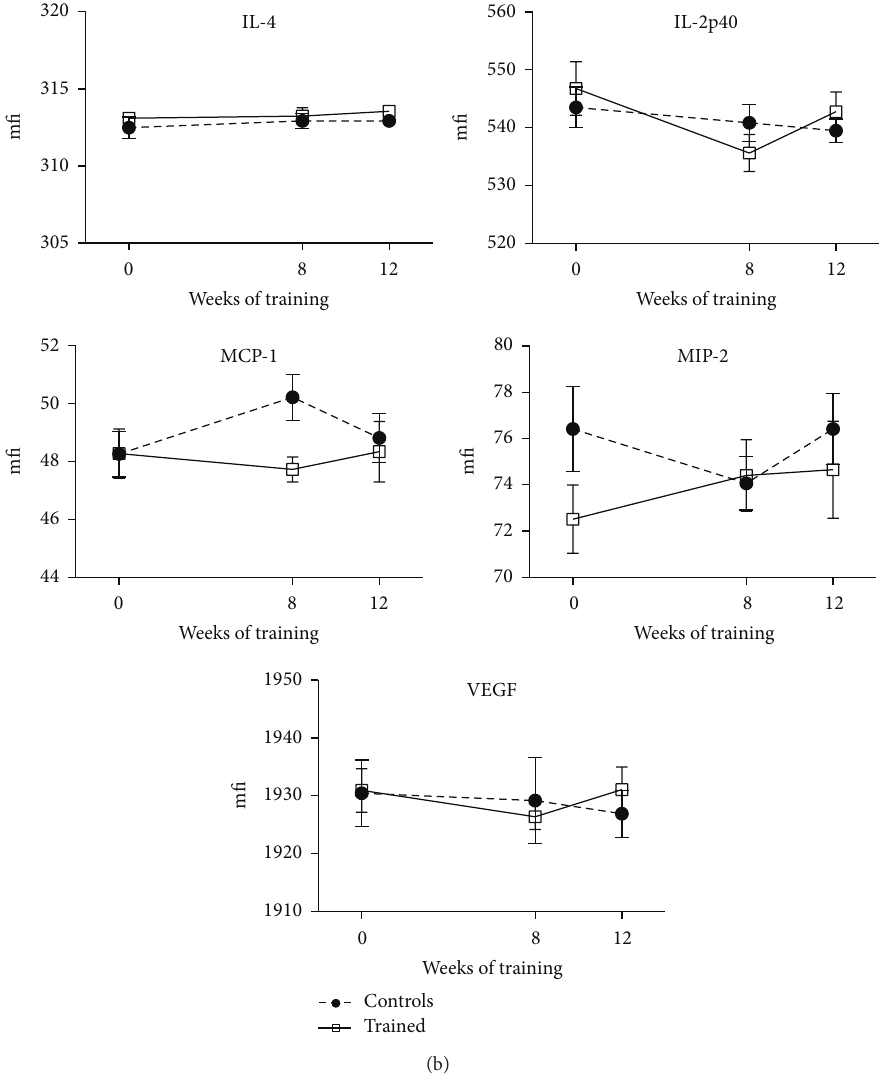
Figure 7: Fluctuations of the cytokines in all NOD mice, throughout the entire duration of the 12-week endurance training program. Results are shown as means and SEM (mfi = mean fluorescence